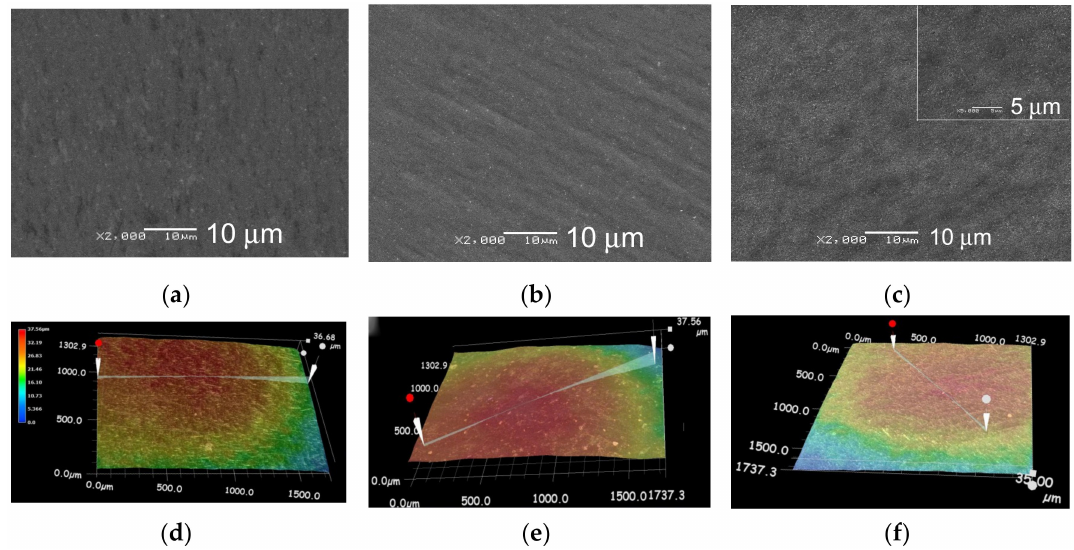
Figure 4. Surface characterization of CP-Ti by SEM of ( a ) polished, and ( b ) 400 ◦ C, and ( c ) 600 ◦ C heat-treated specimens and stereo imaging showing surface contours of ( d ) polished, and ( e ) 400 ◦ C and ( f ) 600 ◦ C heat-treated